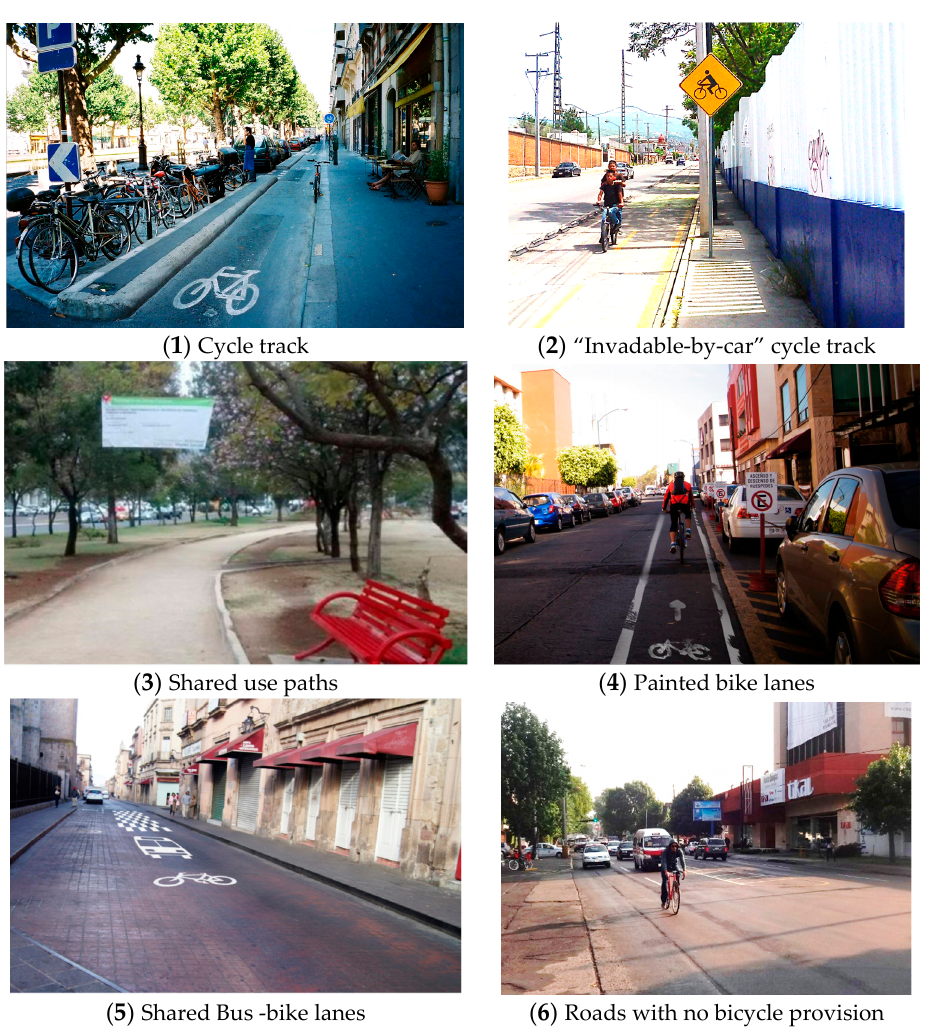
Figure 2. Types of bicycle environments included.